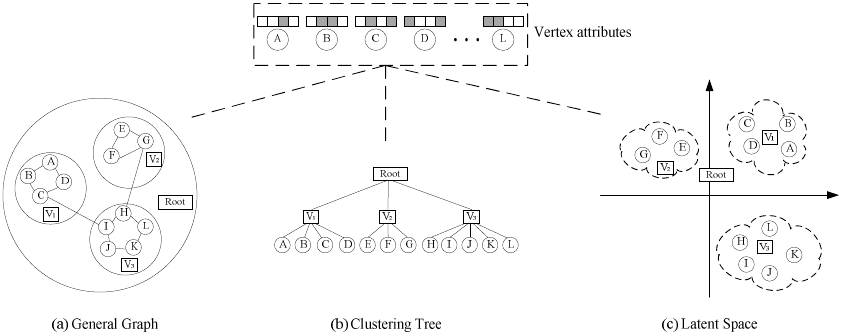
Figure 2. The correspondence between the general attributed network and the hierarchical la- tent space.